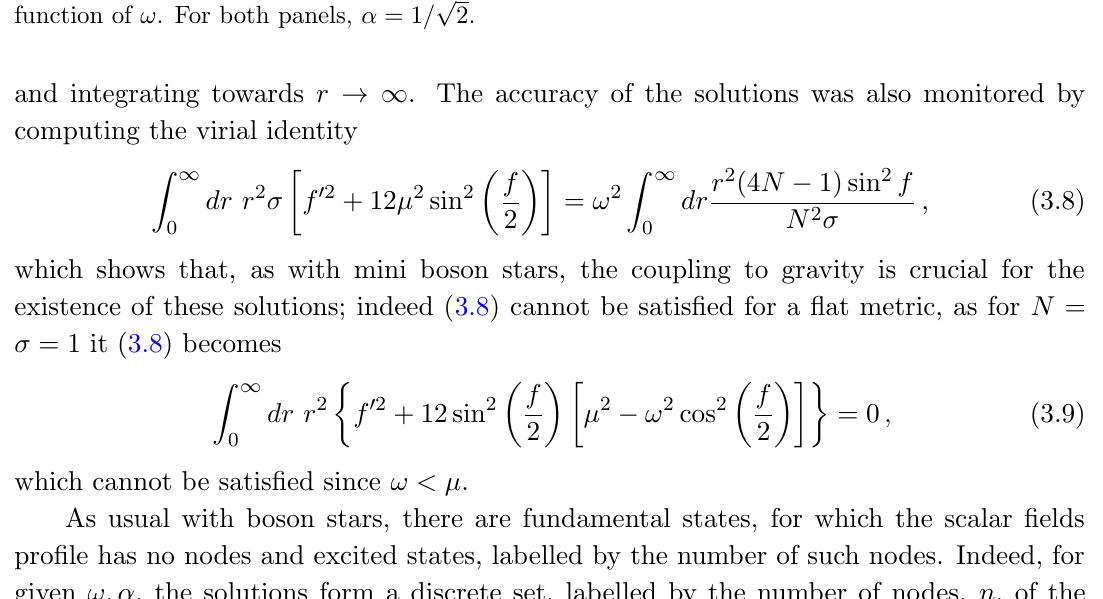
Figure 1 . Spherically symmetric gravitating O(3) solitons. (Left panel) The radial pro(cid:12)le functions of an illustrative solution, which has w=(cid:22) = 0 : 74. (Right panel) The mass and Noether charge as p function of ! . For both panels, (cid:11) = 1 =